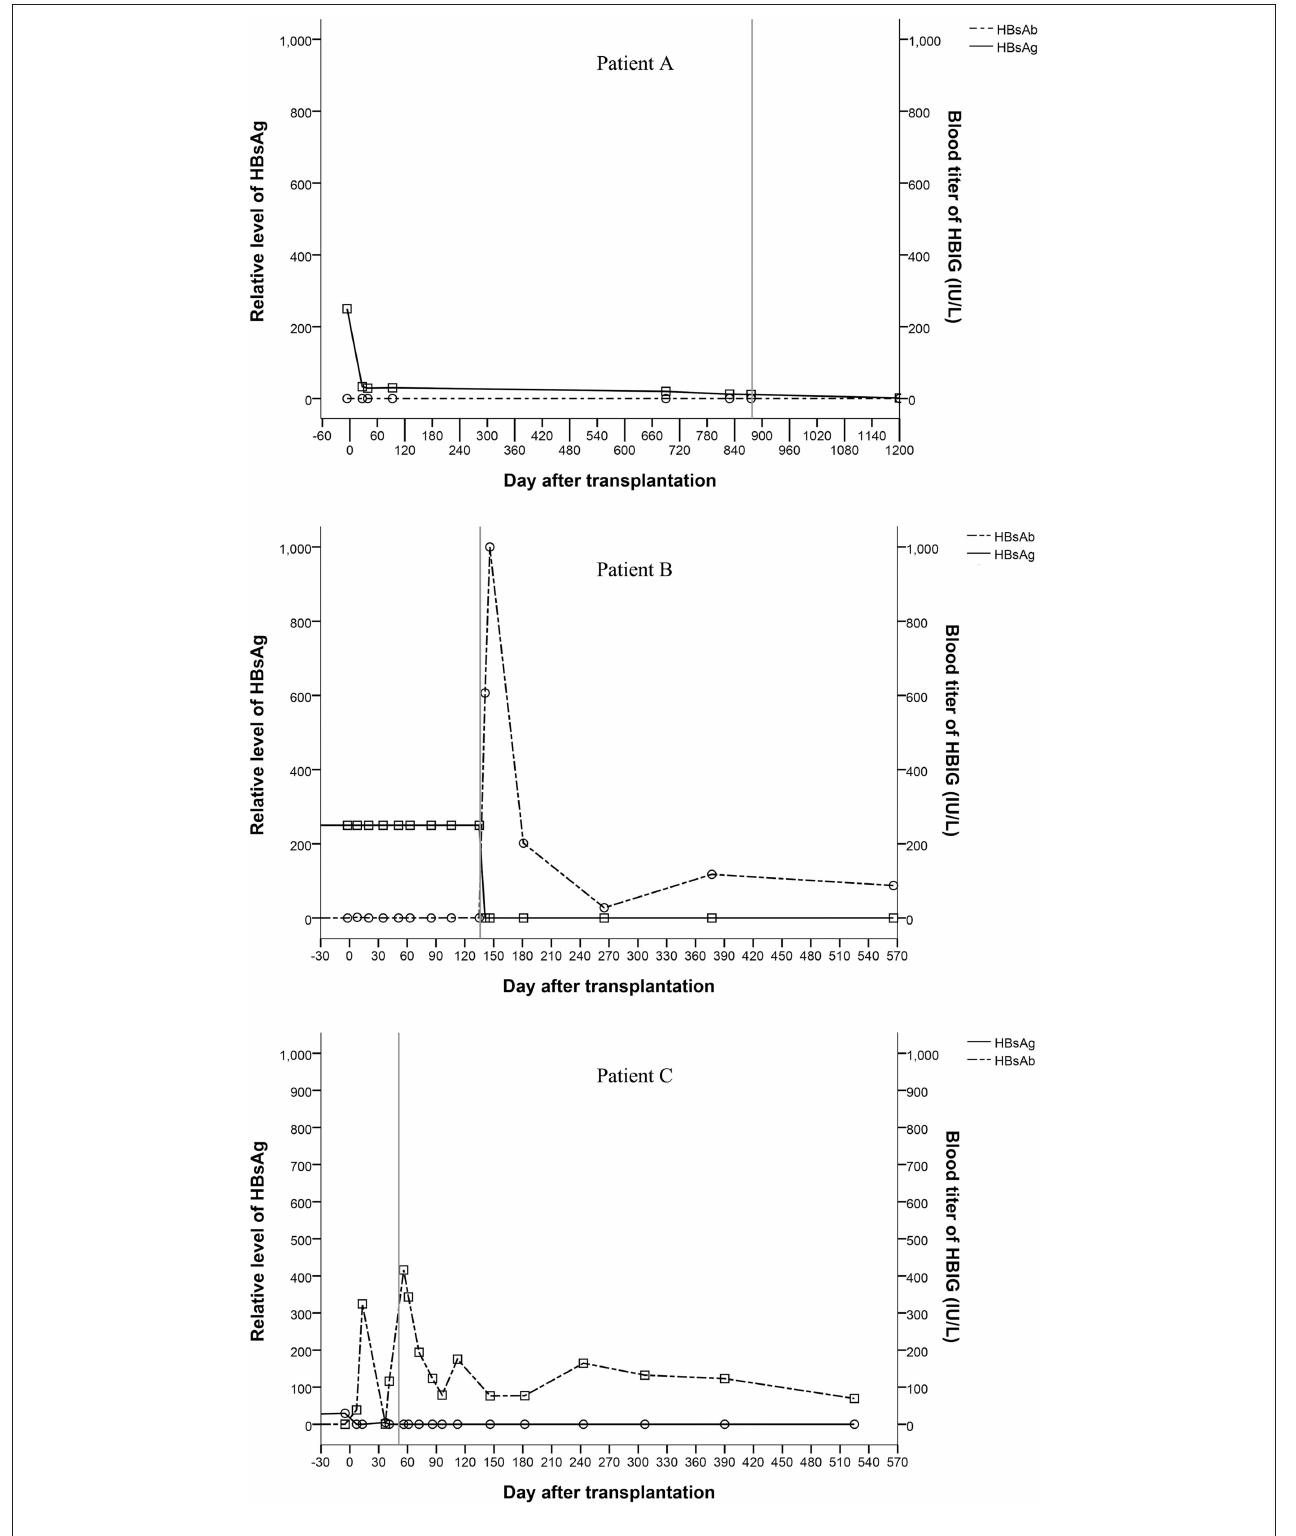
FIGURE 3 | Changes of serum markers for HBV (the vertical line shows the date of the hepatectomy of the remnant native liver).